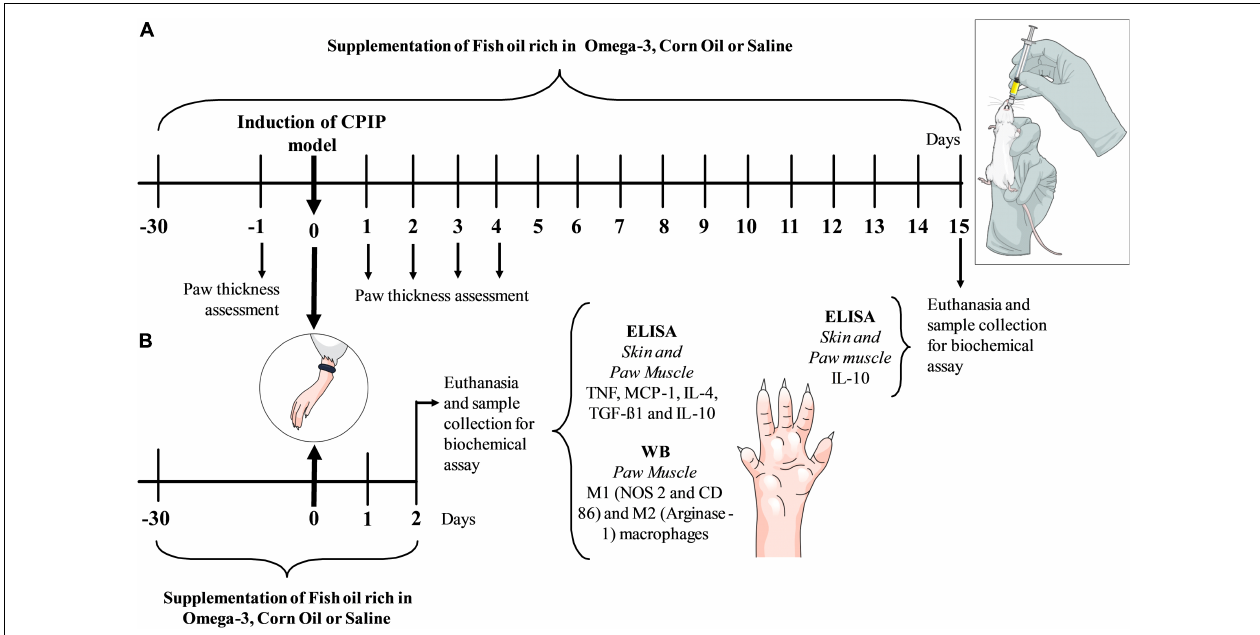
FIGURE 1 | Experimental design with chronic omega-3 supplementation for 30 days and then baseline assessment of paw thickness with a micrometer ( µ m) before the ischemia and reperfusion procedure. Subsequently, the CPIP animal model was induced. The omega-3 supplements continued daily up to the 4th day after the induction of the model when daily assessments of paw thickness were performed. Following 15 days, structures were removed for an ELISA biochemical analysis (A) . In the second experiment, animals received the same supplementation protocol before the induction of the CPIP model and up to 2 days (48 h) after the induction of the model, where structures were removed for the biochemical ELISA and WB assays (B) . CPIP, Chronic Post-Ischemia Pain; WB, Western Blotting; ELISA, Enzyme Immunosorbent